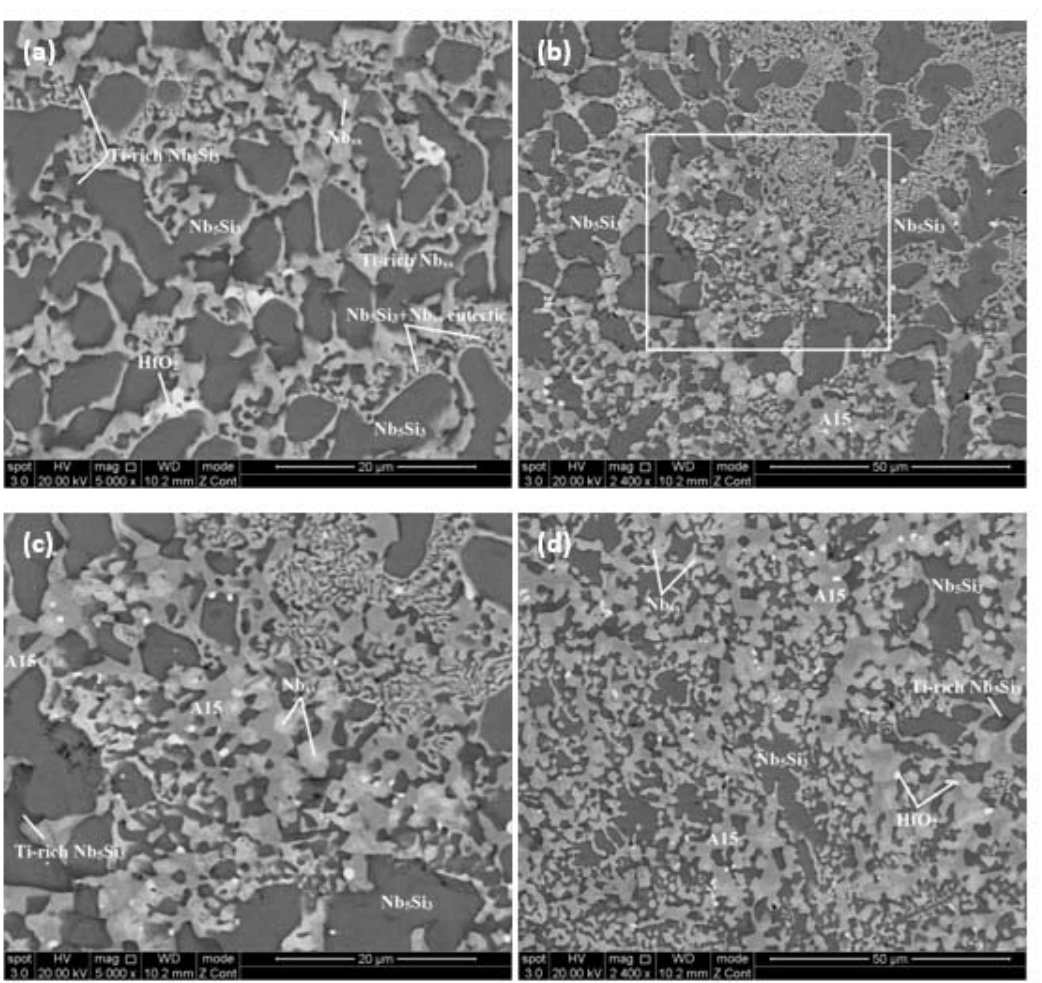
Figure 5. BSE images of the microstructure of JZ2-AC in ( a ) bulk, ( b ) and ( c ) the transition from the bottom to the bulk and ( d ) bottom of the button. ( c ) Corresponds to the area shown by square in ( b ). The average composition of the alloy after the heat treatment (JZ2-HT) was 51Nb-12Ti-21.1Si Table 4. Weight gains and oxidation rate constants of the alloys JZ1 and JZ2 after isothermal oxidation at 800 and 1200 °C for 100 h.